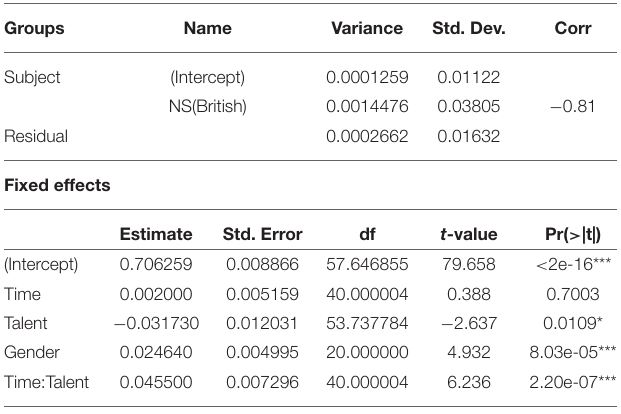
TABLE 3 | Random and fixed effects for the linear mixed effects model: convergence in the dialogs and subjects’ phonetic talent (significance values for the coefficients are based on t -tests using the Satterthwaite’s method, provided within the lmerTest package). Random effects (observ.: 80, groups: Subject, 20)